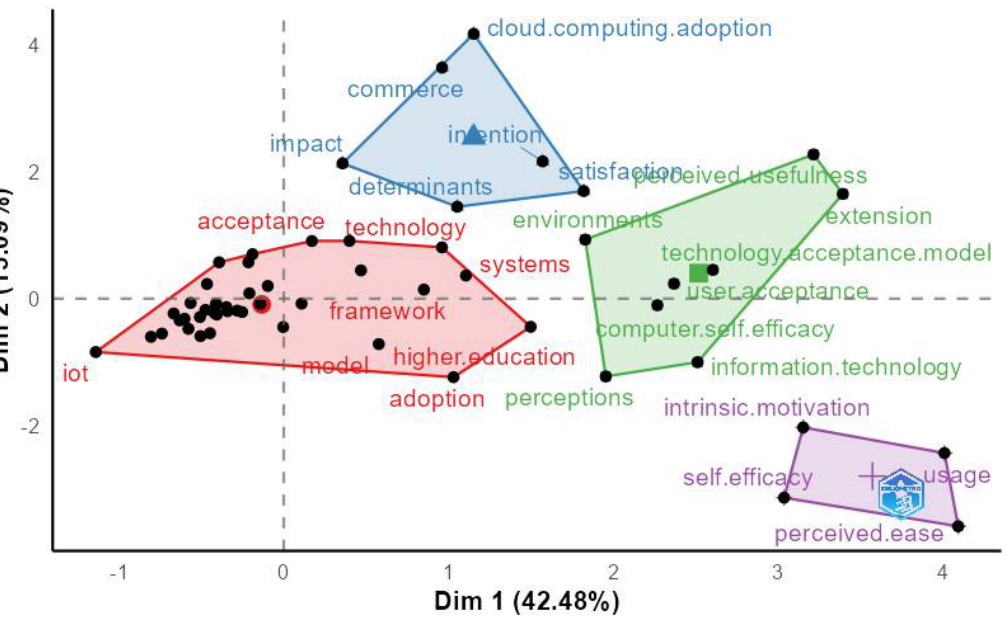
Figure 11. Conceptual Structure Map: MCA.